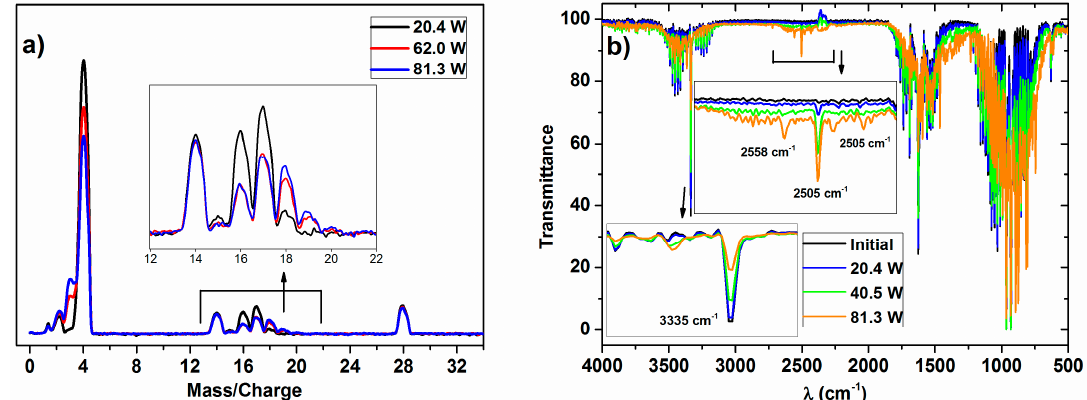
Figure 1. ( a ) Comparison of selected mass spectra recorded for the NH 3 /D 2 /N 2 mixture plasma treated at increasing powers in the dielectric barrier discharge (DBD) reactor; ( b ) infrared spectroscopy (IR) spectra of the outlet gases in the same experiments. The insets show an enlarge scale of the zones of bands attributed to differently labelled ammonia molecules (see text).